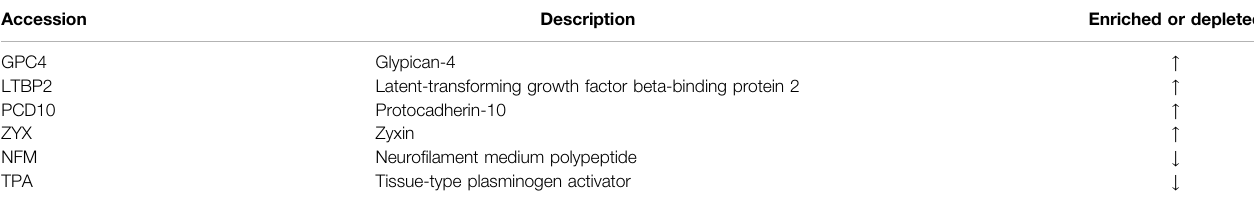
Footnote: Proteins whose levels were elevated by two or more folds in two or more samples of 1-, 5-, and 7-day Dex treated TM cells are listed. Arrows pointing up and down re fl ect an increase and decrease in expression level, respectively.